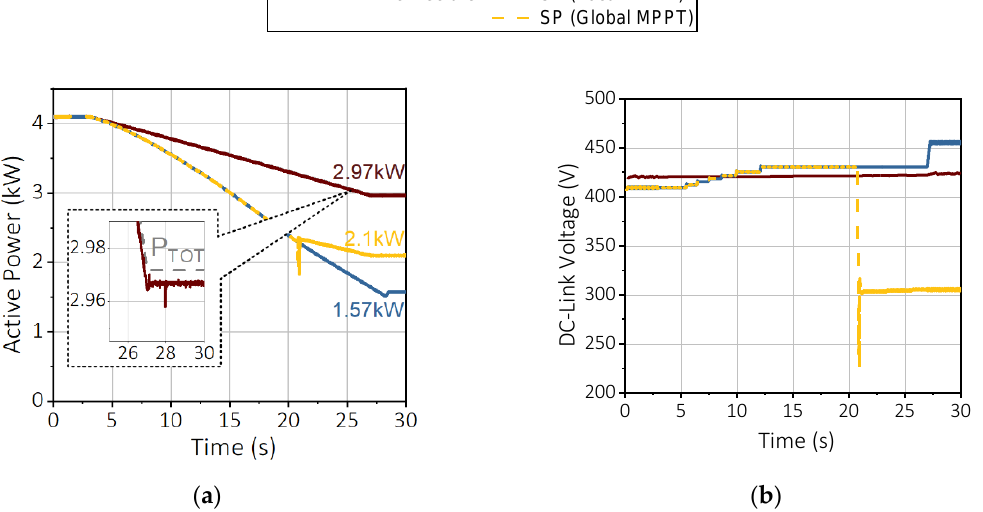
Figure 8. ( a ) Active power fed to the grid and ( b ) DC-bus voltage variation with time for the proposed VMPV under shading pattern B.